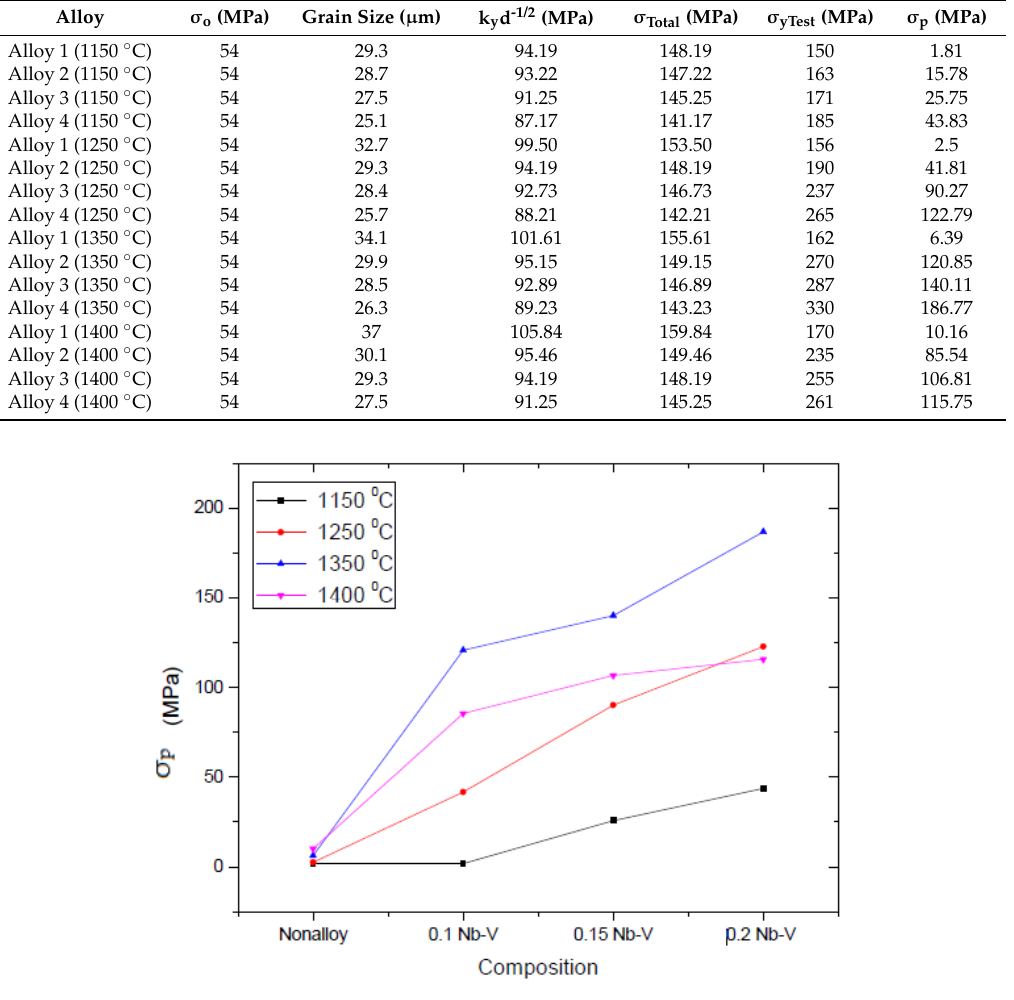
Figure 7. Variation of σ p (the contribution of precipitation and cluster hardening as MPa) values of the PM steel and microalloyed PM steels at different percentage Nb-V content and different